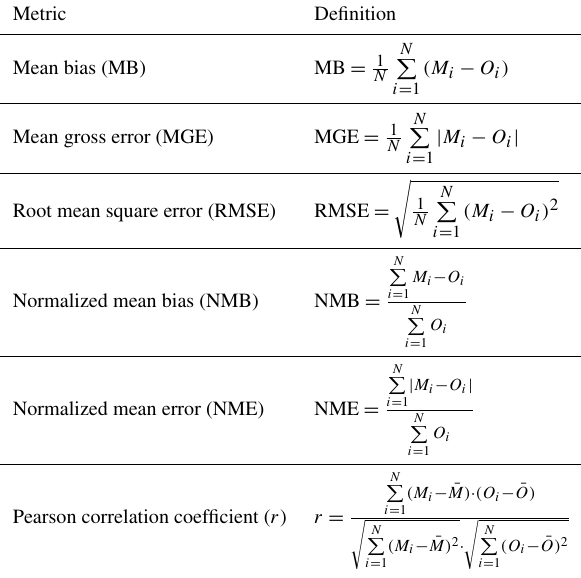
Table 3. Definition of statistical metrics for model performance evaluation. M i and O i stand for modeled and observed values, re- spectively, and N is the total number of paired values.